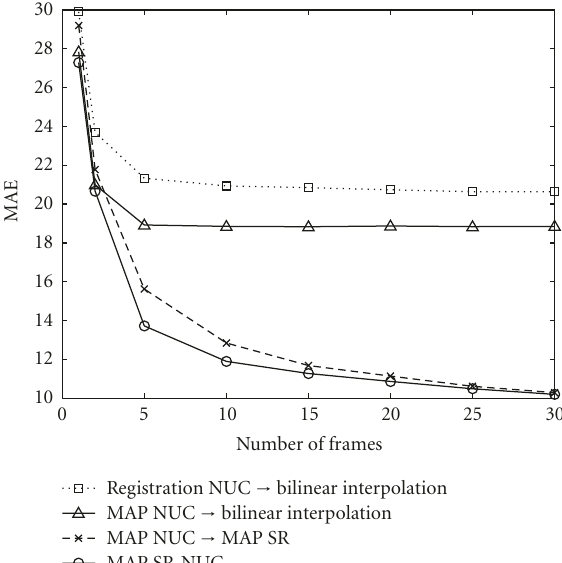
Figure 4: Mean absolute error for the HR image estimate as a func- tion of P (the number of input